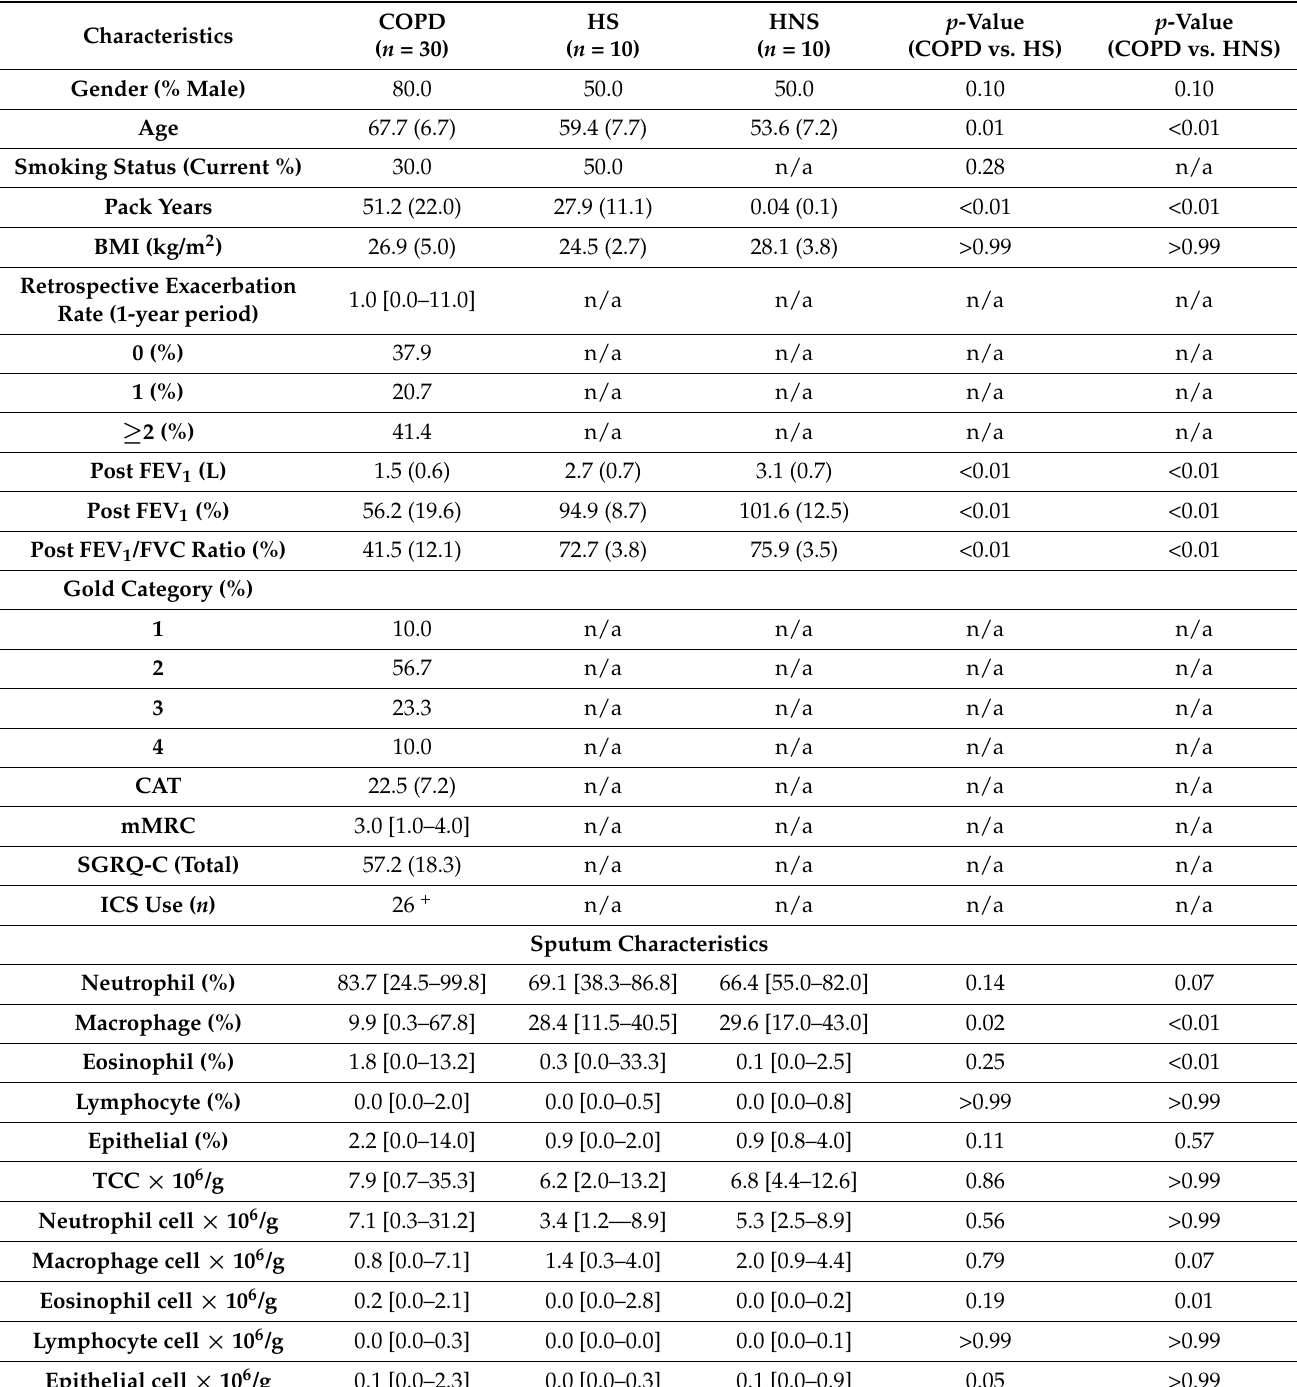
Table 2. Baseline characteristics for COPD subjects, healthy smoking and healthy non-smoking controls in Cohort A ( n = 30, 10 and 10, respectively